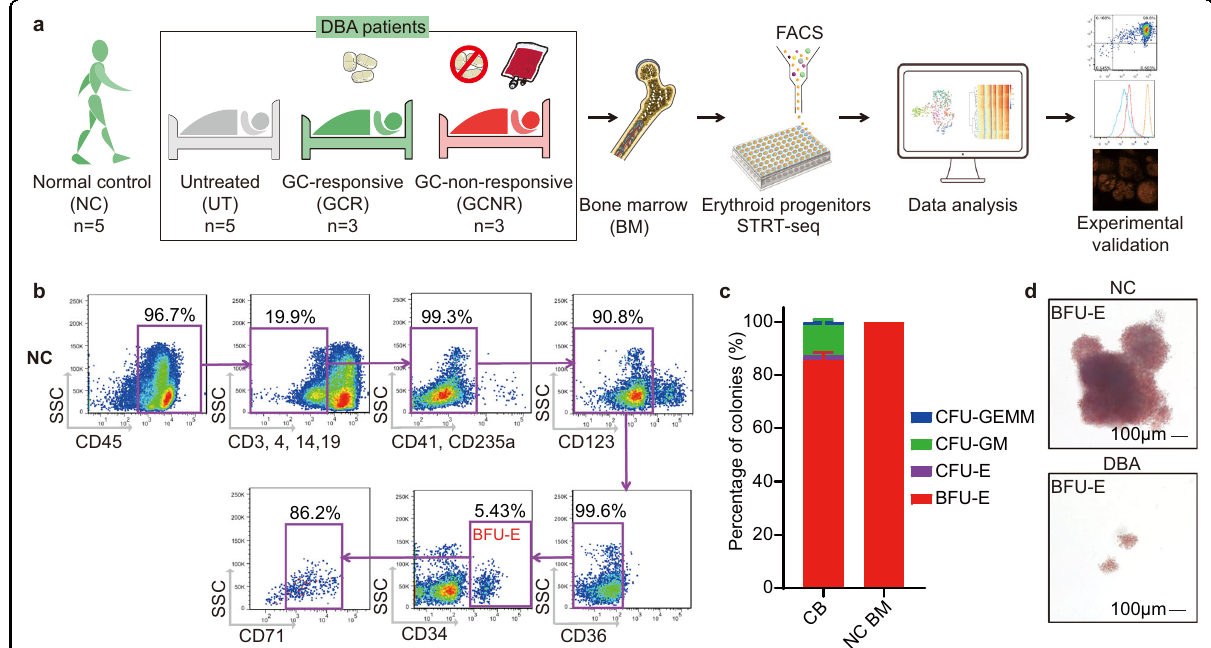
Fig. 1 BM erythroid progenitors in DBA patients show compromised growth. a Schematic illustrating the experimental work fl ow. Bone marrow (BM) erythroid progenitors from healthy individuals (acting as normal controls, NC) and DBA patients, who were subcategorized into untreated (UT), glucocorticoid (GC)-responsive (GCR) and GC-non-responsive (GCNR) groups, were sorted using fl ow cytometry and processed for single-cell RNA-seq (scRNA-seq) using modi fi ed STRT-seq, followed by data analyses and experimental validation. b Representative FACS plots showing the gating strategies used for isolation of BFU-E cells from NCs, which were immunophenotypically de fi ned as CD45 + CD3 − CD4 − CD14 − CD19 − CD41 − CD235a − CD123 − CD36 − CD34 + . c The percentage of colonies generated from FACS-sorted cells (BFU-E: CD45 + CD3 − CD4 − CD14 − CD19 − CD41 − CD235a − CD123 − CD36 − CD34 + ) from cord blood (CB) and BM mononuclear cells. We seeded the sorted cells from the CB of three individuals and BM of one individual due to the limited healthy BM sample. Results are represented as mean±SEM. d Micrographs of representative BFU-E colonies differentiated from sorted BFU-E cells of NC and DBA UT patients on day 14 of the colony forming unit assay. Scale bars, 100 μ m. See also Supplementary Fig. S1, Tables S1,